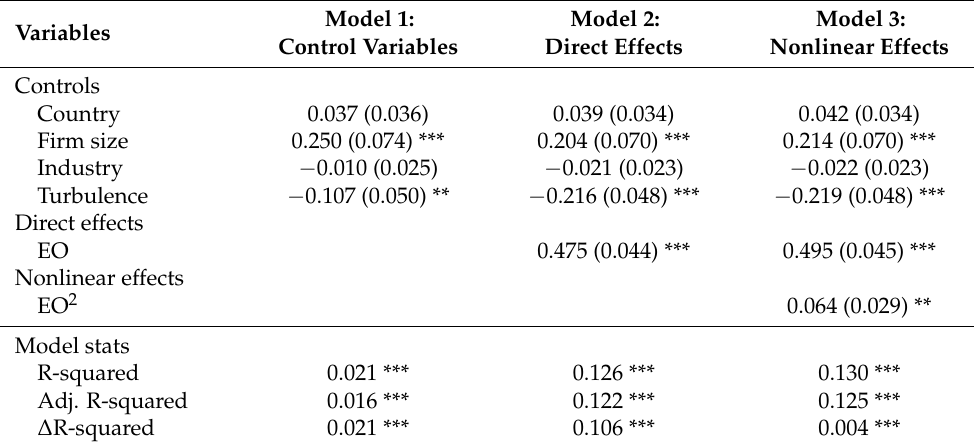
Table 4. Results of hierarchical regression analysis for profit-to-sales (n =